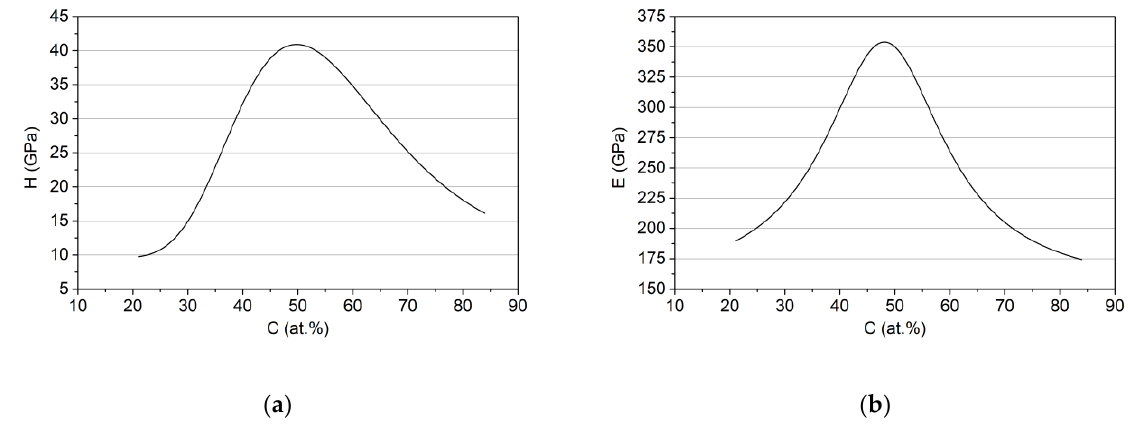
Figure 5. Dependence of the hardness ( a ) and Young’s modulus; ( b ) of Zr‒C coatings on the concentration of carbon. Yield strength Y and tangent modulus TM in the function of carbon concentration are assumed to be proportional, respectively, to H(C), E(C) functions (Figure 5a,b) which is a general rule for a wide class of materials [52–54]. The dependence between the mean value of the compressive stresses in the Zr–C coating in the ( x,y ) plane and the carbon concentration was also determined (Figure 6).